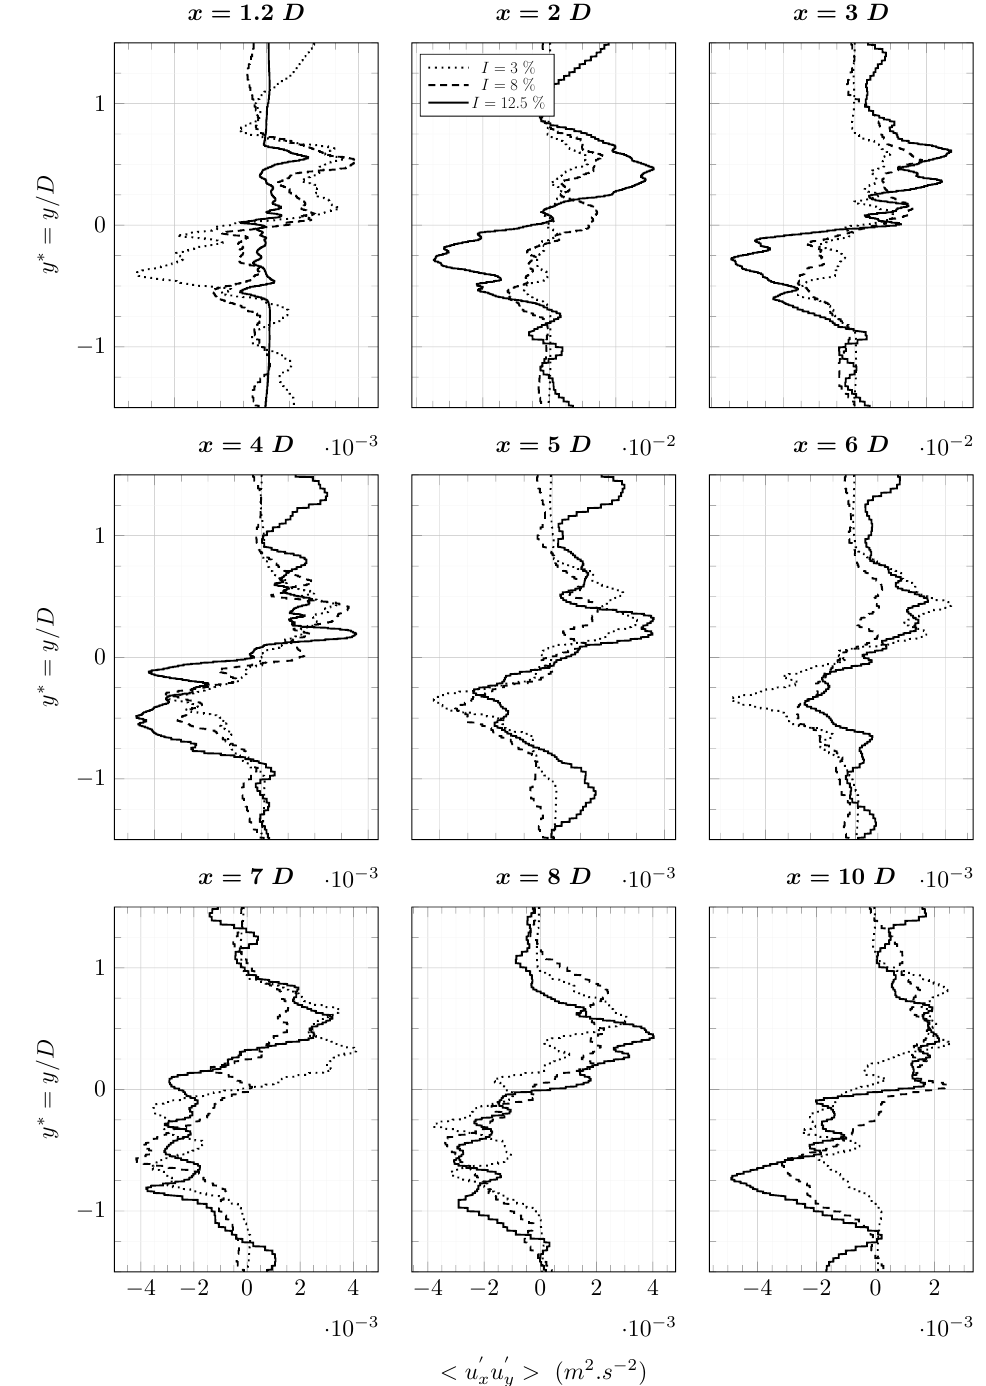
Figure 23. Average turbulence intensity profiles I 2 D turbine simulated in LBM-LES at TSR = 3.67 with upstream turbulence intensities of I = [ 3,8,12.5 ]